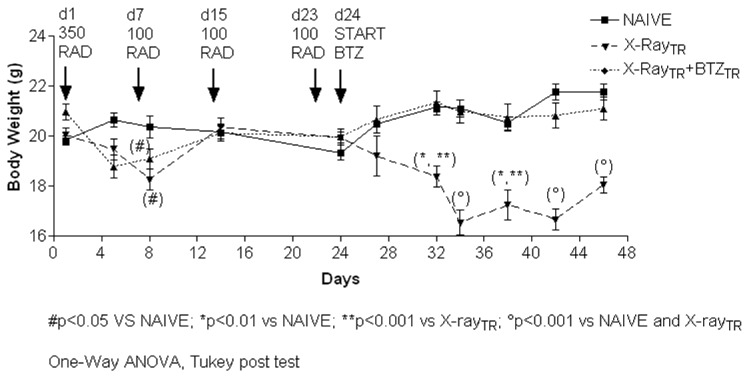
Body weight, experiment 2.Body weights were measured twice a week to monitor X-Ray irradiation and bortezomib-induced toxicity. X-Ray-treated animals showed an initial slight body weight decrease on day 4 and 8 then resumed a normal growth trend similar to naïve animals. Starting from the second bortezomib administration (day 32) animals showed a marked and statistically significant decrease of body weight that persisted till the end of the experimental period.